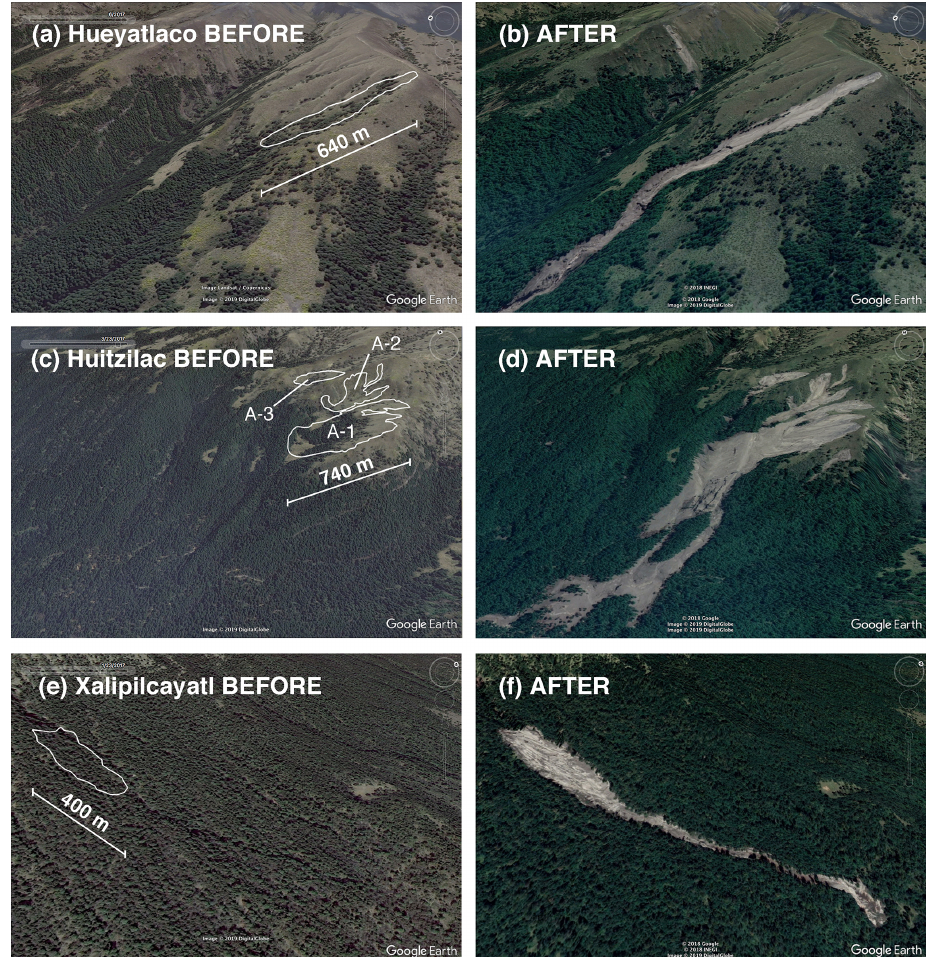
Figure 7. Comparison of 3D views on the detachment areas in the headwaters of the Hueyatlaco (a, b) , Huitzilac (c, d) , and Xalipilcayatl (e, f) ravines before and after the larger landslides. Images from Google Earth (© Google 2018, © INEGI 2018, and © DigitalGlobe 2019).